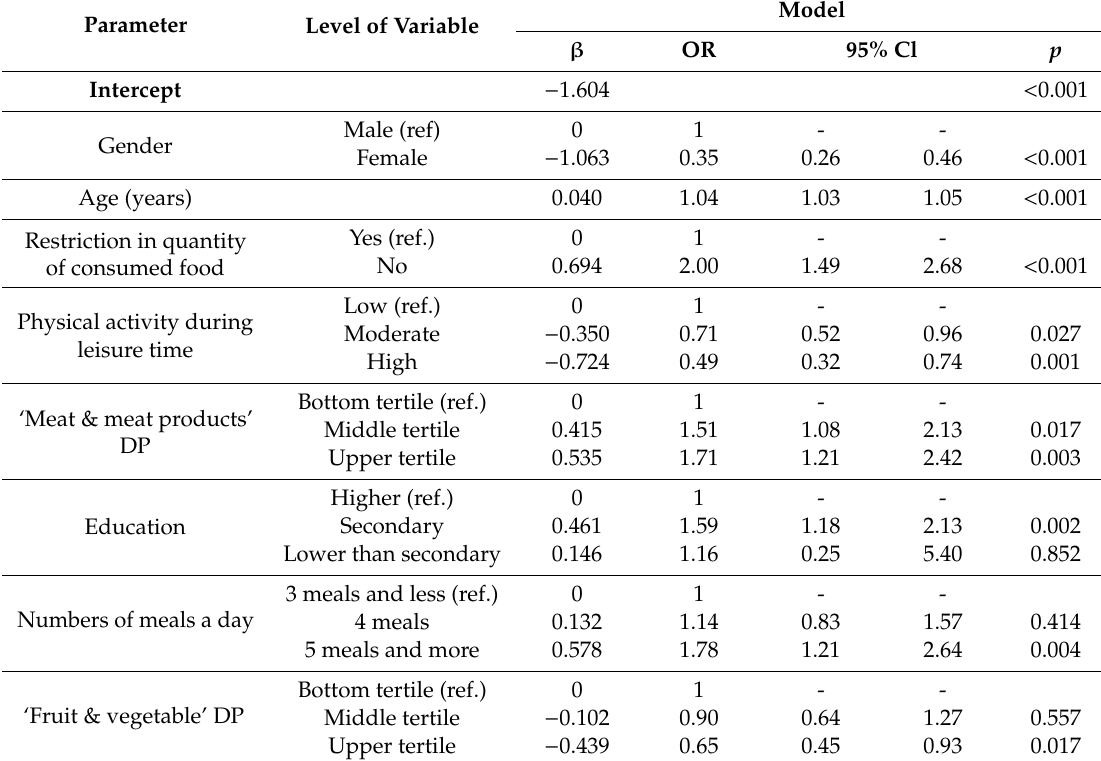
Table 4. Overweight and obesity (BMI ≥ 25 kg / m 2 ) odds ratios (OR; 95% CI) in the study